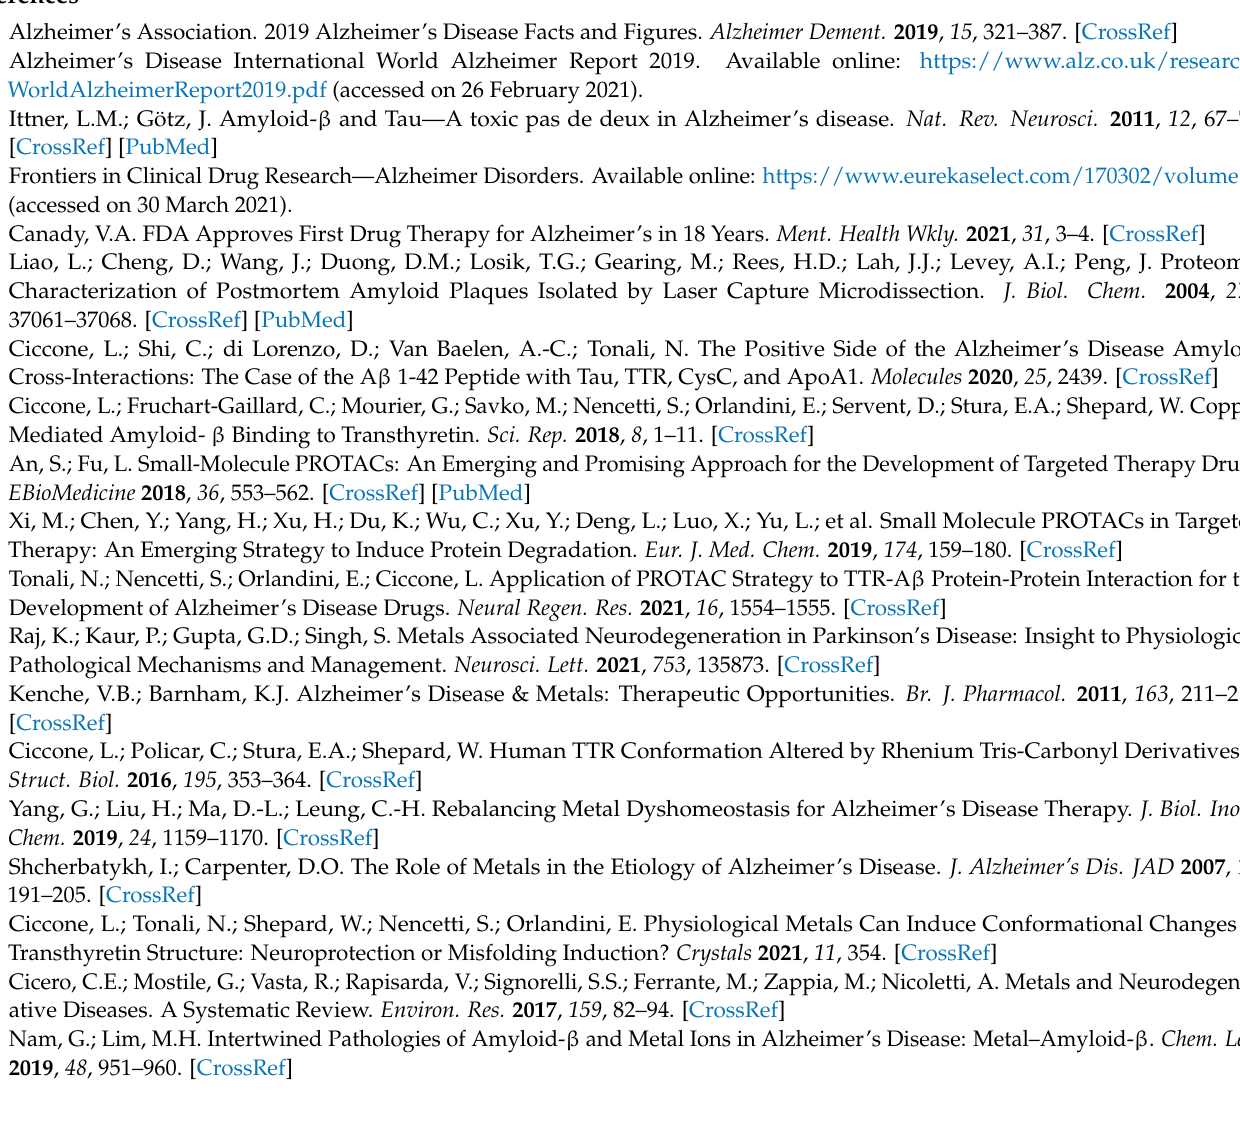
Supplementary Materials: The 1 H-NMR, 13 C-NMR and the mass spectra for compounds 1a – e